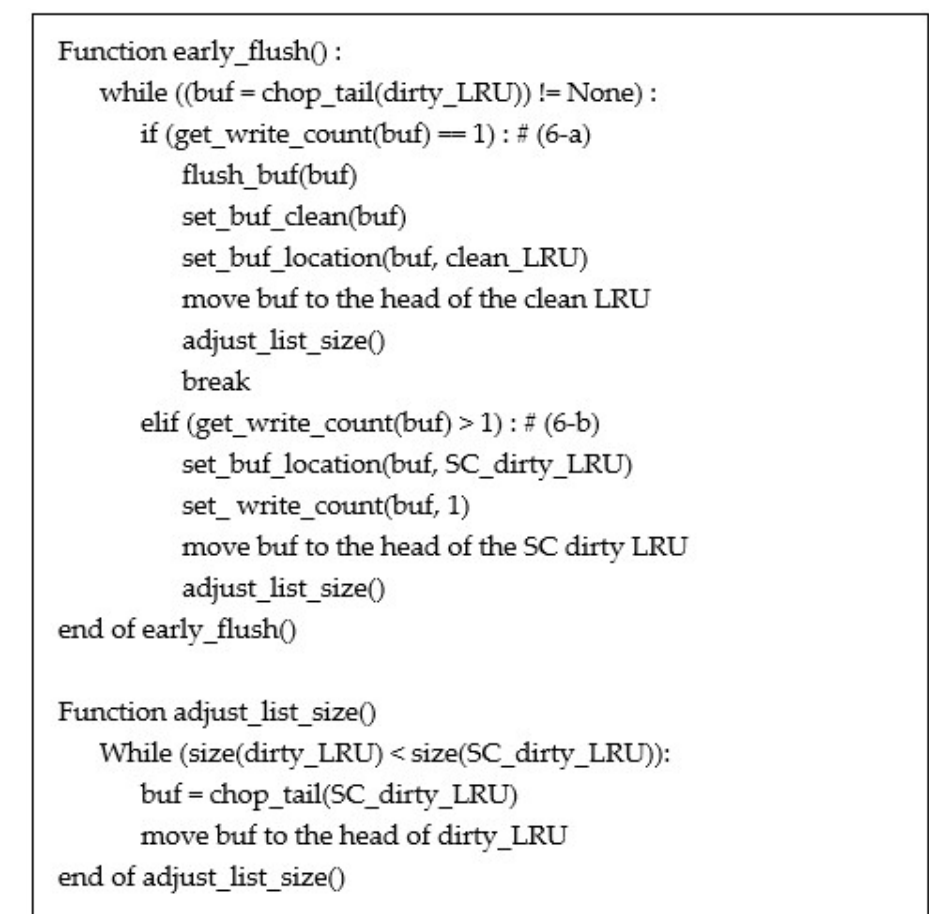
Figure 3. The pseudo code of the early flush.